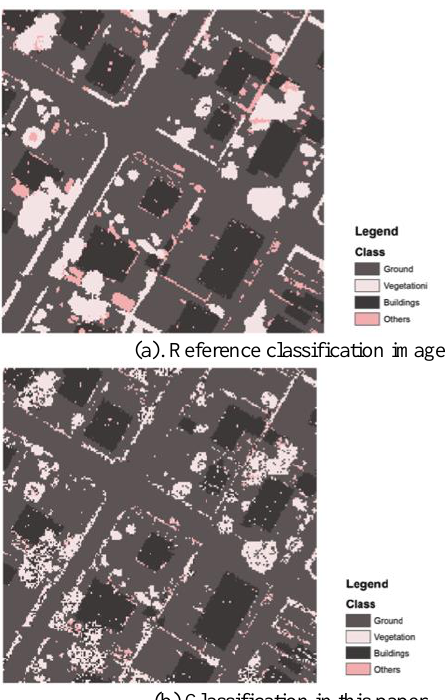
Figure 4. Classification reference and result for comparison